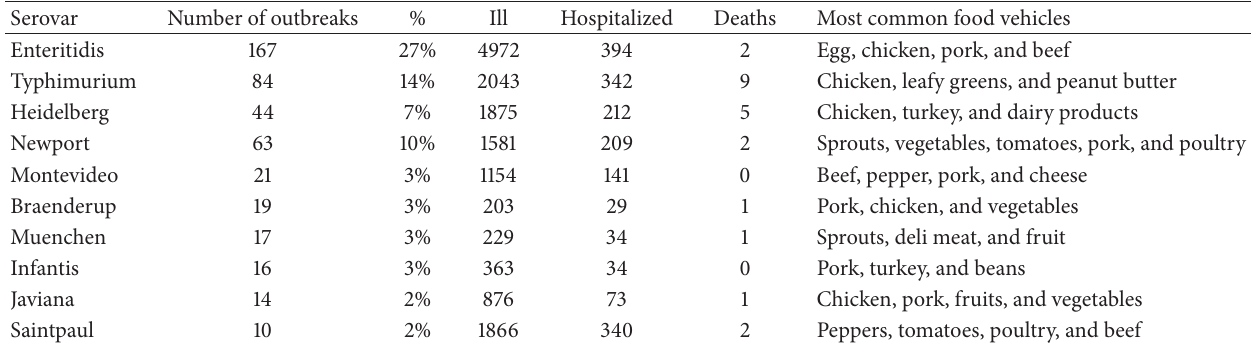
Table 4: Examples of Salmonella serovars isolated from foodborne outbreaks in the US in humans and most common food items related to each serovar from 2007 to 2011 [14].